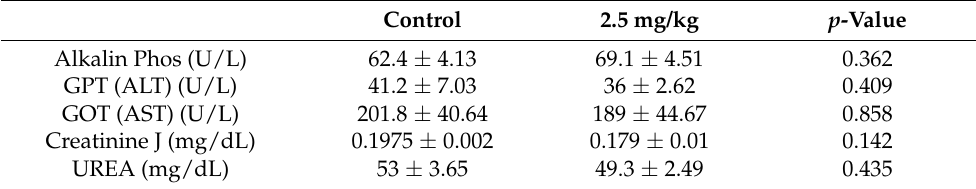
Table 4. Liver and kidney functions following the treatment with the CS extract. At the end of the treatment period, mice were euthanized, and blood was drawn immediately from the mice hearts. The results presented are the mean ± SE, n = 6. Statistical significance was determined by the Student’s t -test. Statistical analyses indicated that there was no significant difference between the data from the controls and the treated